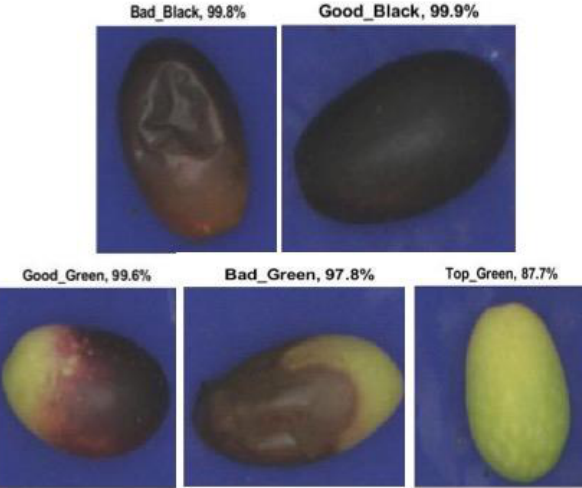
Figure 7. Example of olives’ classification through the transfernet learning. Table 5. Results of the external test of calibrated olives images. The rows report the sorting machine output, while the columns report the conveyor belt results.